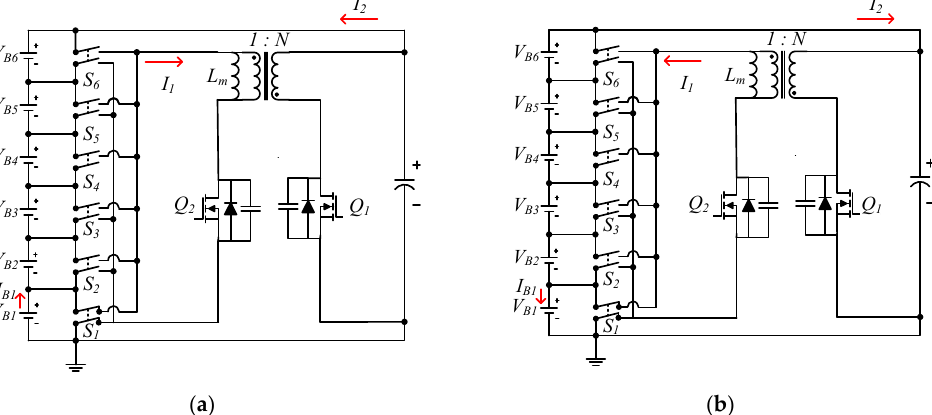
Figure 4. Schematic diagram of active cell balancing circuit based on bidirectional flyback converter in ( a ) boost mode ( b ) buck mode.